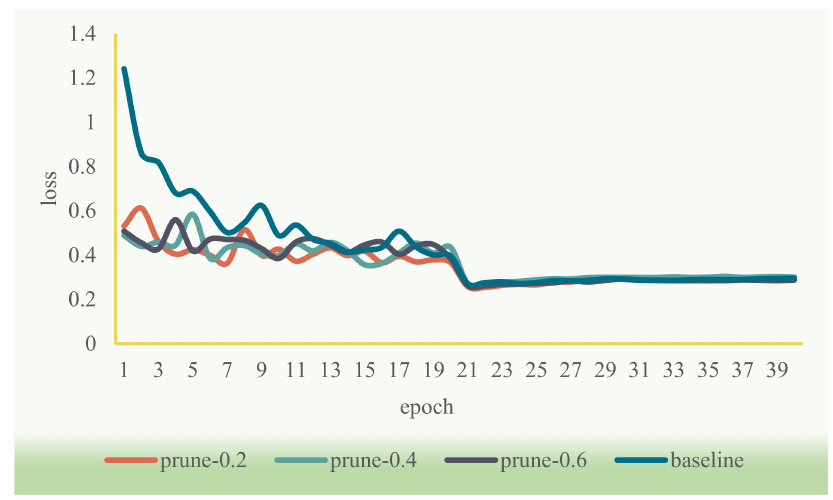
Figure 8. Loss function comparison chart.